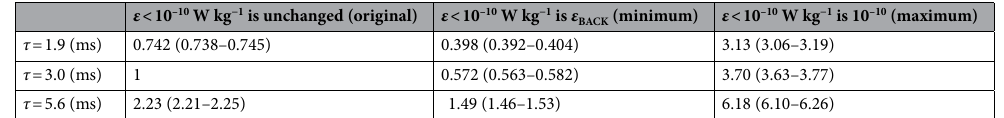
Table 1. Uncertainties in ε based on observations. The geometric means of the ratios between the modified ε (changing τ and ε in ε < 10 –10 W kg −1 ) and the original ε (the case of the middle row, the left column), with 95% confidence intervals of the bootstrap method are in the parentheses. The 200 m-mean data set of the ε values corresponding to all observation points of the eight cruises were used. The three values correspond to the uncertainty of the individual thermistors whose time constant based on spectrum double-pole correction ranges between 1.9 and 5.6 ms. Another source of uncertainty is the weak turbulence region, ε < 10 –10 W kg −1 , where ε is set to the background value (the middle columns), ε BACK , or fixed at 10 –10 (the right column). ε BACK is based on the observed minimum diapycnal diffusivity, i.e. ε BACK = K ρ · N 2 ·Γ −1 = 10 –7 · N 2 ·0.2 –1